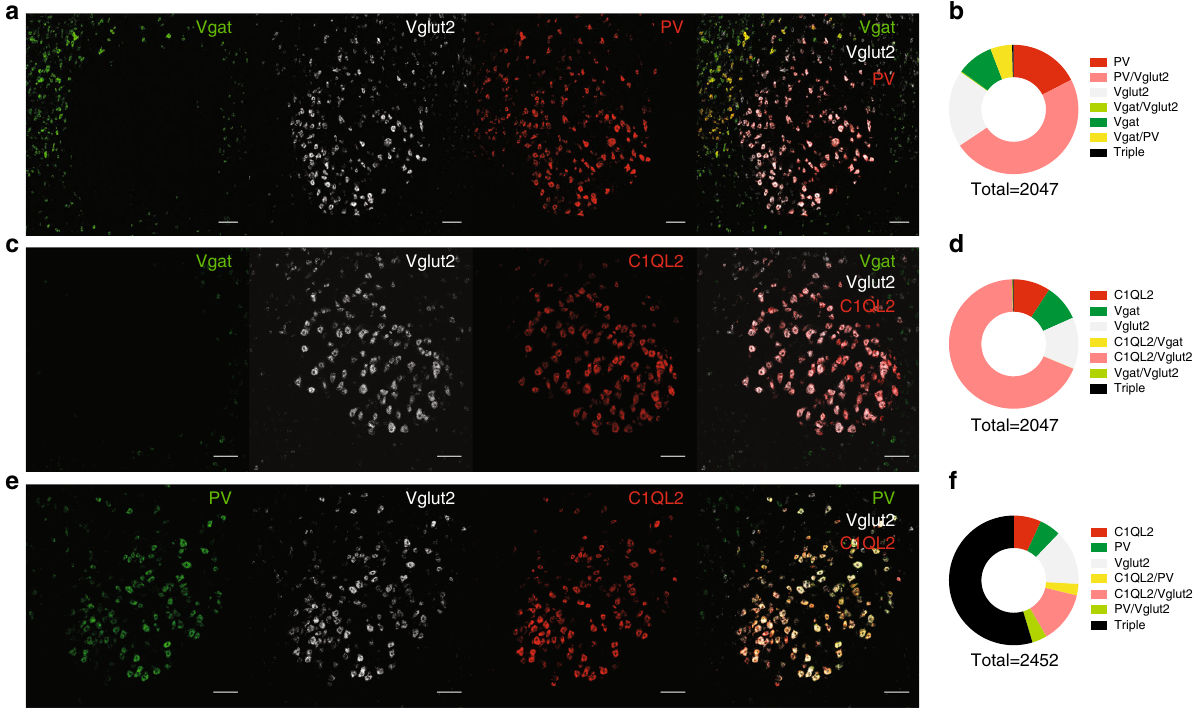
Fig. 3 Vglut2-positive cells co-express PV and C1QL2. a , b Confocal images of Vgat, Vglut2 and PV mRNA ( a ) with corresponding quanti fi cation (scale bar, 100 µ m) in b . c , d FISH for Vgat, Vglut2 and C1QL2 ( c ) and quanti fi cation in d . e , f mRNA for PV, Vglut2 and C1QL2 ( e ) with quanti fi cation in f . ( n = narrower action potential (Fig. 4i) and had similar resting whole-cell patch-clamp experiments in RN-containing brain sli- membrane potentials to Vglut2-negative cells (Fig. 4j). ces from Vglut2-CRE mice 34 injected with a viral vector coding the expression of channelrhodopsin — 2 (AAV5-EF1 α -DIO- ChR2-EYFP) (Fig. 4a), used to photo-tag Vglut2-positive neurons Vglut2- cells exhibit speci fi c output targets . To further char- (Fig. 4b). Overall RN Vglut2-positive cells were able to sustain a acterize the Vglut2-positive neurons, we assessed their down- much higher fi ring frequency in response to larger current stream projections and injected Vglut2-CRE mice in the RN with injections, displayed a larger capacitance, higher rheobase, a CRE-dependent viral vector coding a GFP tagged form of saturating currents and maximum fi ring rate (Fig. 4c – h), a